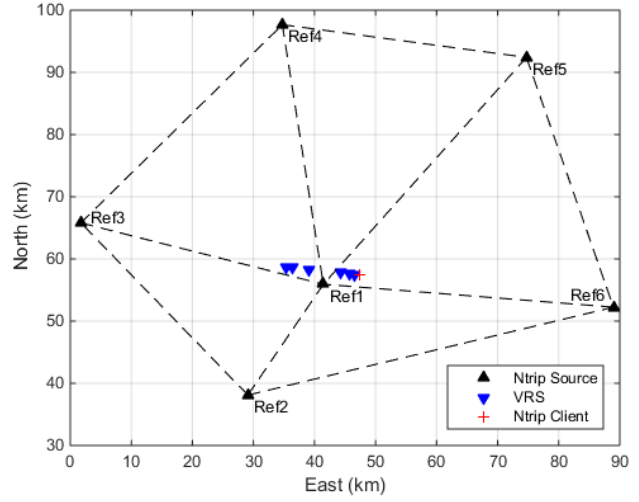
Figure 12. Distribution of the reference stations of the tested network RTK system.